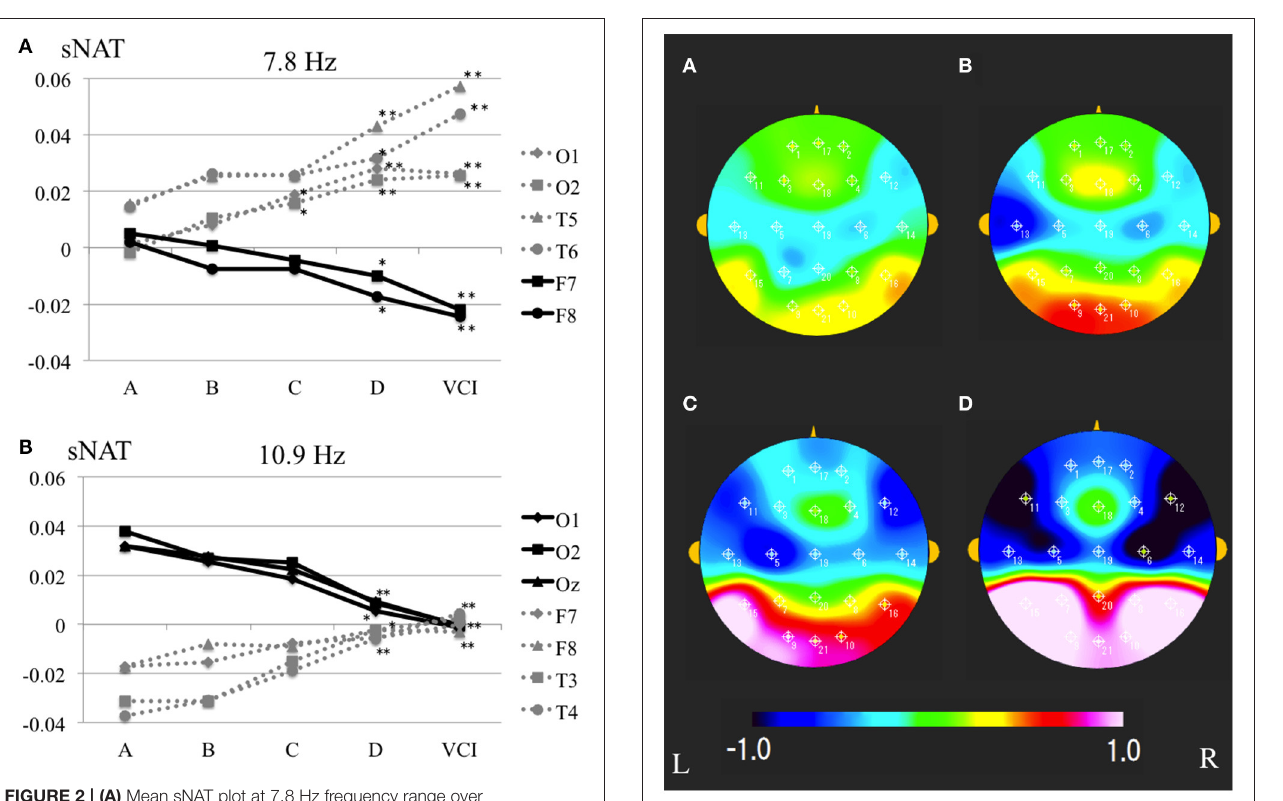
FIGURE 3 | Mean sNAT map at 7.8 Hz frequency range for (A) group B, (B) group C, (C) group D, (D) VCI group, respectively. The colorbar indicates the range of z-scores in comparison with control group A: Green indicates normal spectrum intensity. Red and blue indicate hyperspectrum intensity and hypospectrum intensity, respectively. L, left; R,